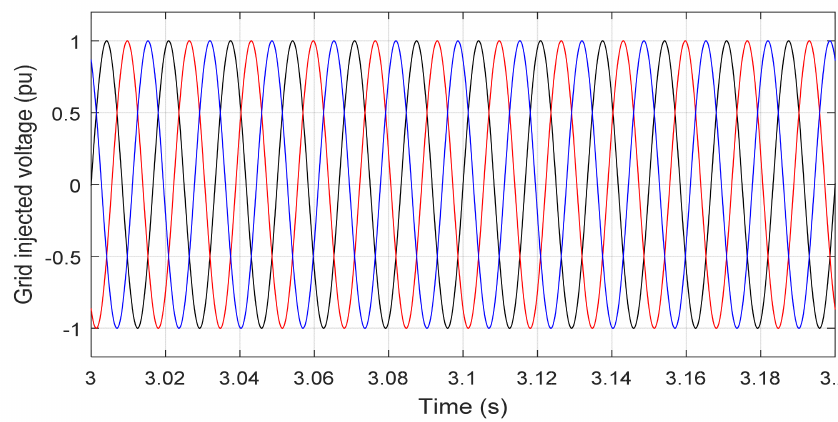
Figure 11. Zoom on reactive power.